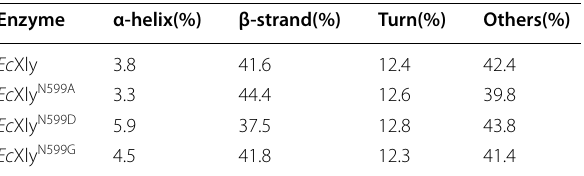
Table 2 The secondary structure proportion of Ec Xly and its mutants ( Ec Xly N599A , Ec Xly N599D and Ec Xly N599G